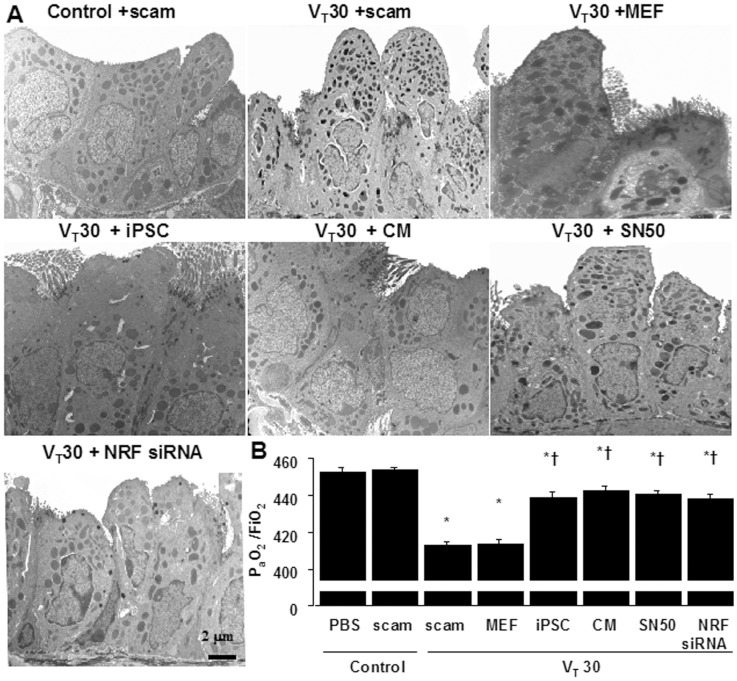
Restoration of ultramicrostructure and oxygenation by iPSCs or iPSC-CM, SN50, or NKRF siRNA.(A) A transmission electron microscopic image revealing the restoration of airway ultramicrostructure by iPSCs, iPSC-CM, SN50, or NKRF siRNA. (B) Restoration of oxygenation by iPSCs, iPSC-CM, SN50, or NKRF siRNA in wild-type mice receiving high-tidal-volume ventilation was shown. Data shown here are the mean ± SD of five independent experiments. *P<0.05 vs. Non-ventilated control treated with PBS, †P<0.05 vs. VT30-ventilated mice treated with scam or MEF. Scale bars represent 2 µm.